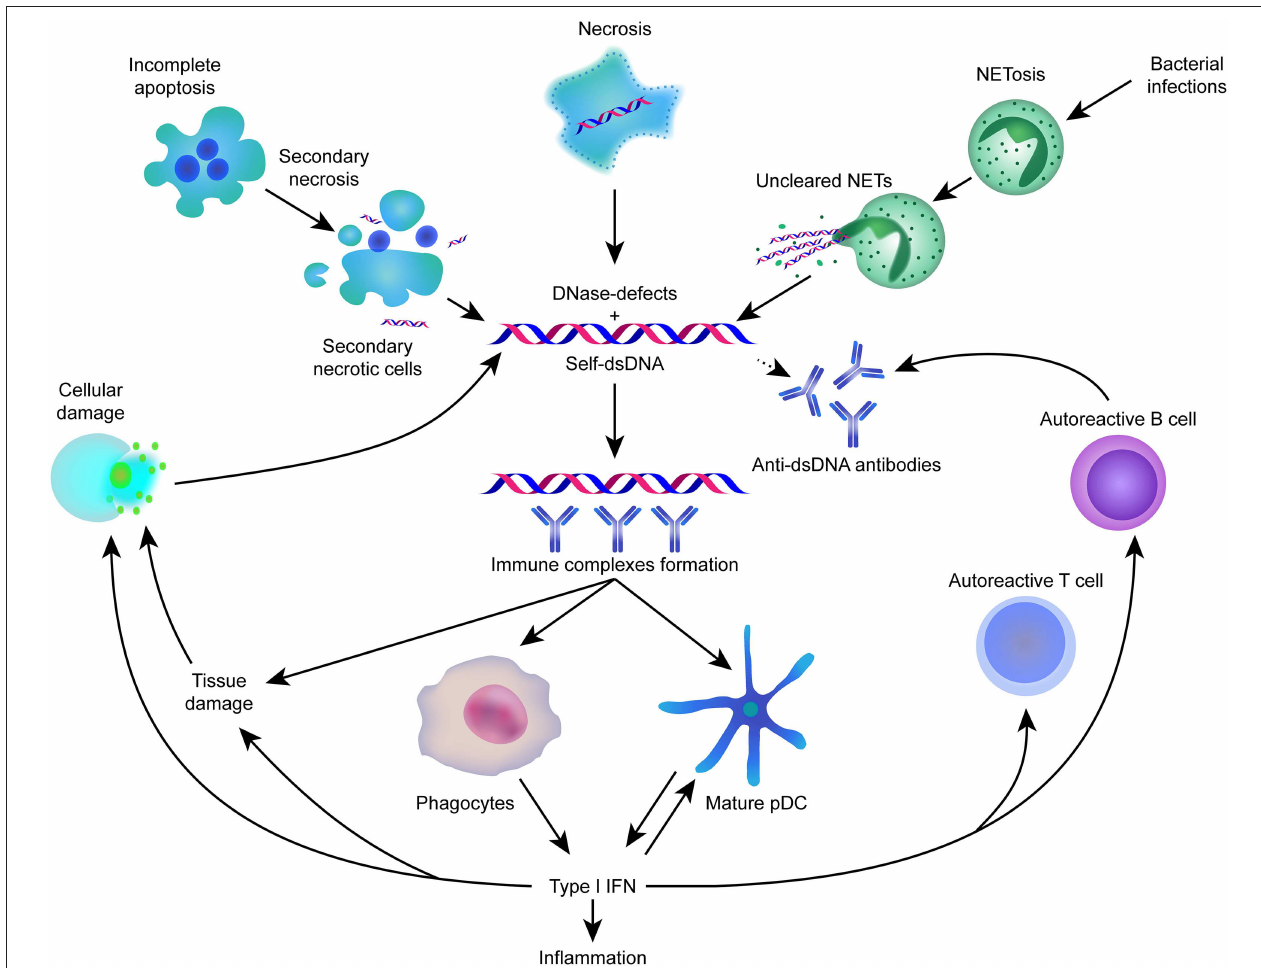
FIGURE 2 | Self-dsDNA released during cell death plays an important role in the pathogenesis of